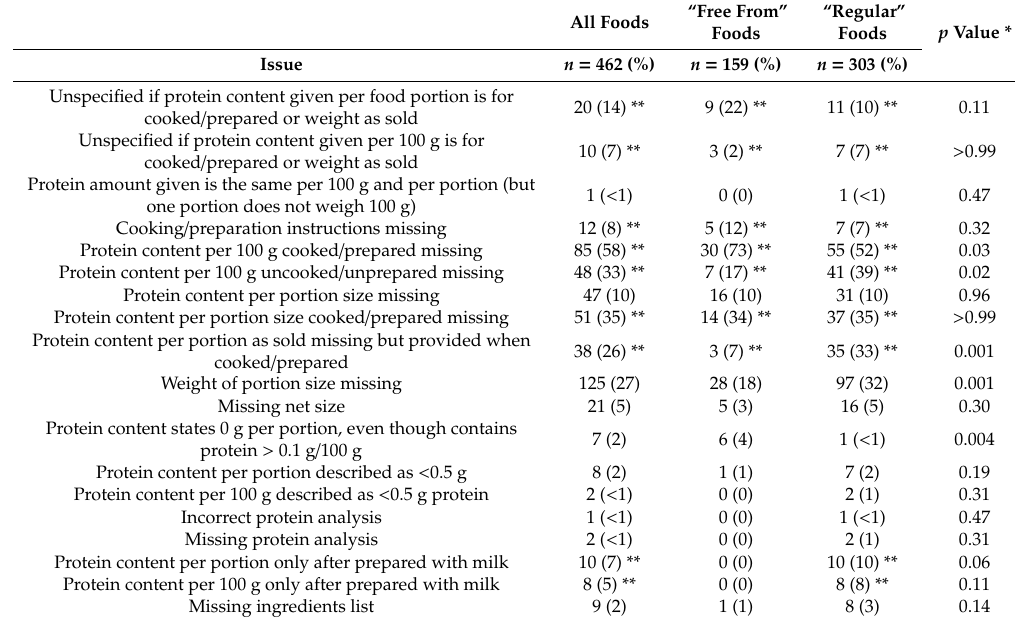
Table 2. Type of misleading, omitted, or erroneous (MOE) information that would a ff ect protein content describing individual foods given on the supermarket